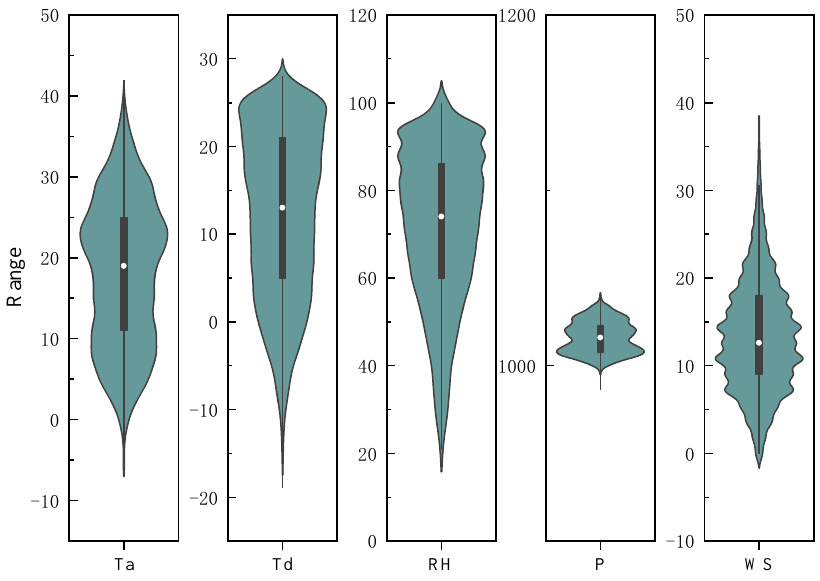
Figure 1. Violin chart of the meteorological parameters.